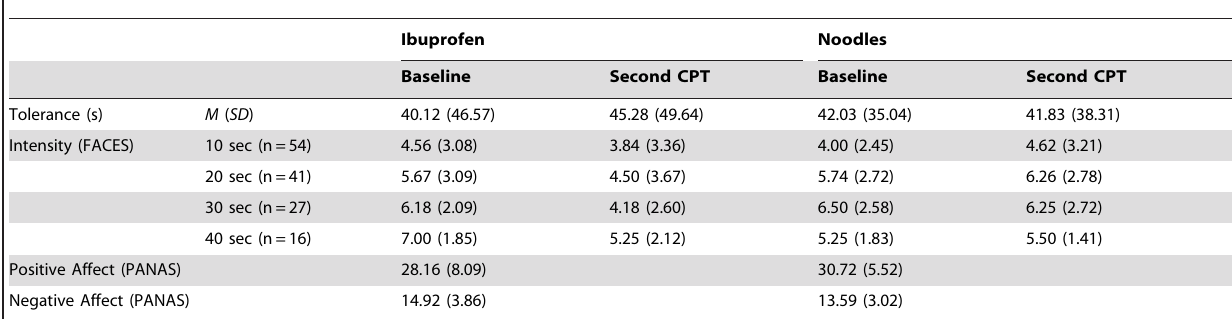
Table 1. Tolerance, intensity and affect means and standard